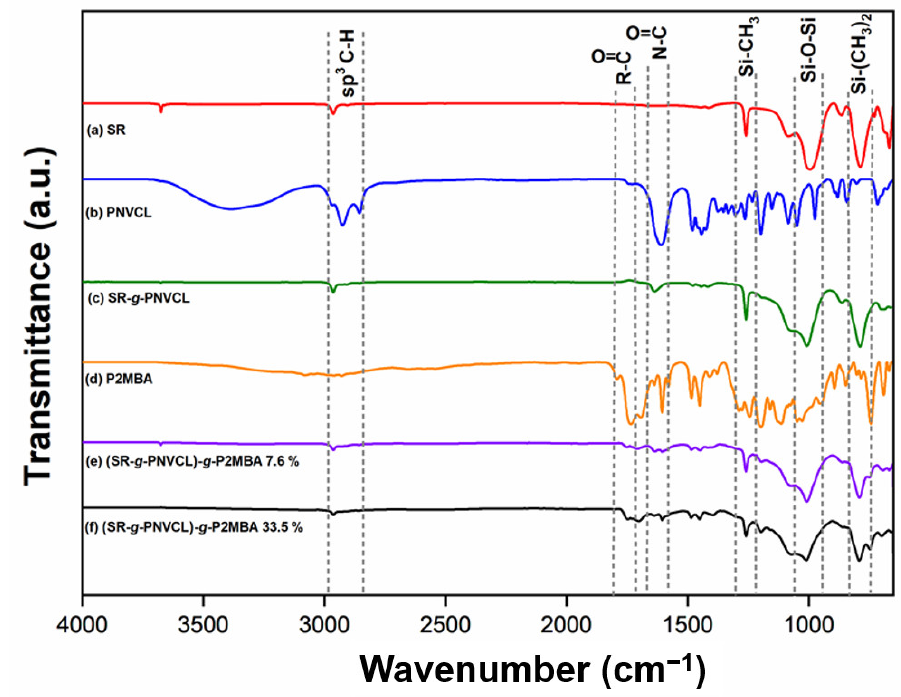
Figure 3. ATR-FTIR spectra of SR ( a ), PNVCL ( b ), SR- g -PNVCL ( c ), P2MBA ( d ), (SR- g -PNVCL)- g -P2MBA 7.6% ( e ), and (SR- g -PNVCL)- g -P2MBA 33.5% ( f ).